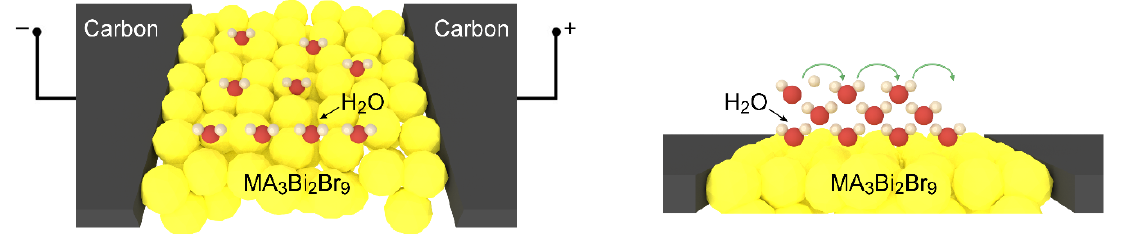
Figure 5. Proposed sensing mechanism. Change in resistivity occurs as a surface phenomenon involving proton hopping between adsorbed molecules. involving proton hopping between adsorbed